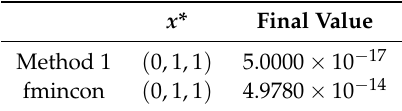
Table 4. Numerical results for Example 2 by Method 1 and